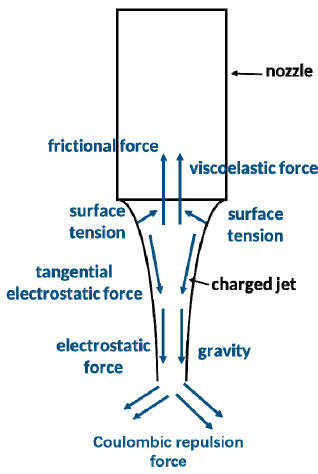
Figure 1. Schematic representation of the formation of cone jet as well as the breakup process of charged jet in electrospraying process indicating the controlling forces.